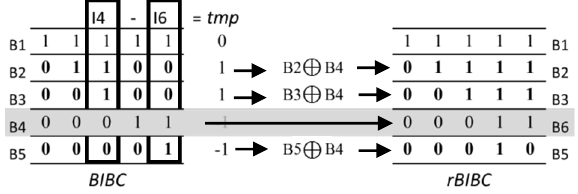
Figure 4. The BIBC and rBIBC